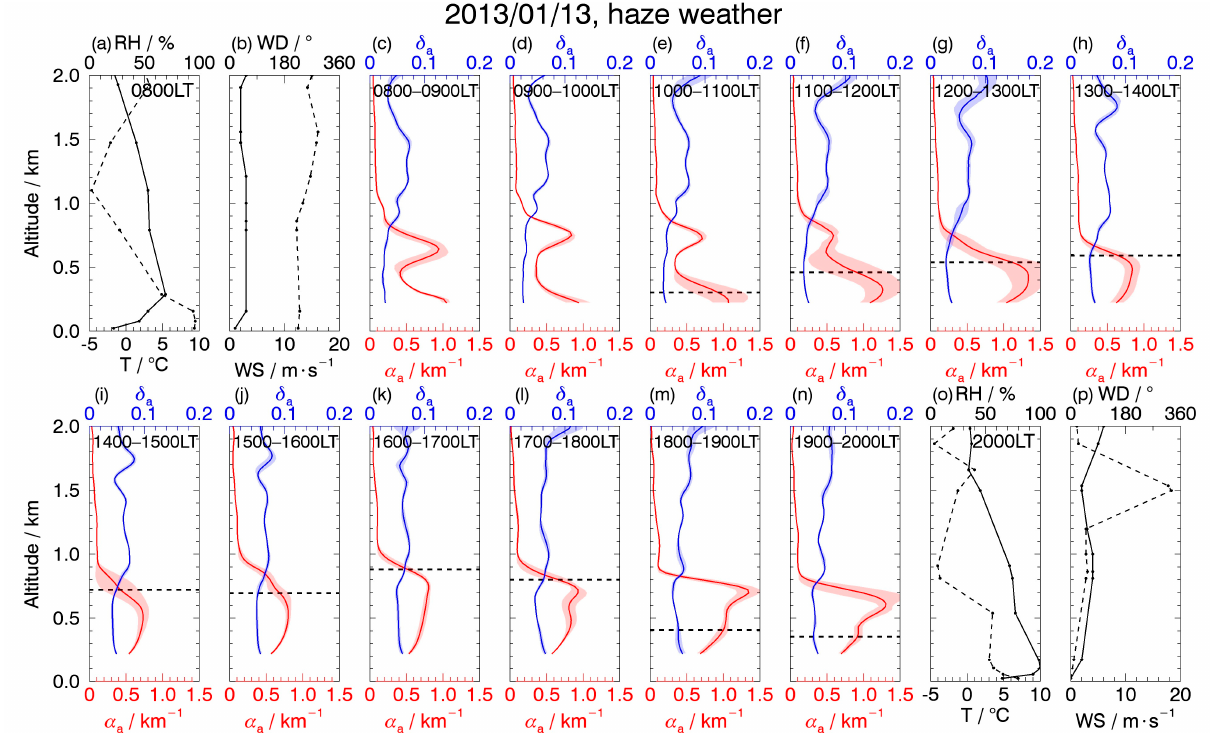
Figure 10. Same as Figure 8 except for 13 January 2013, which was also a hazy day. Aerosol evolution in the ABL on this day was much like that on 10 January except for the formation of a pronounced residual layer in the afternoon.